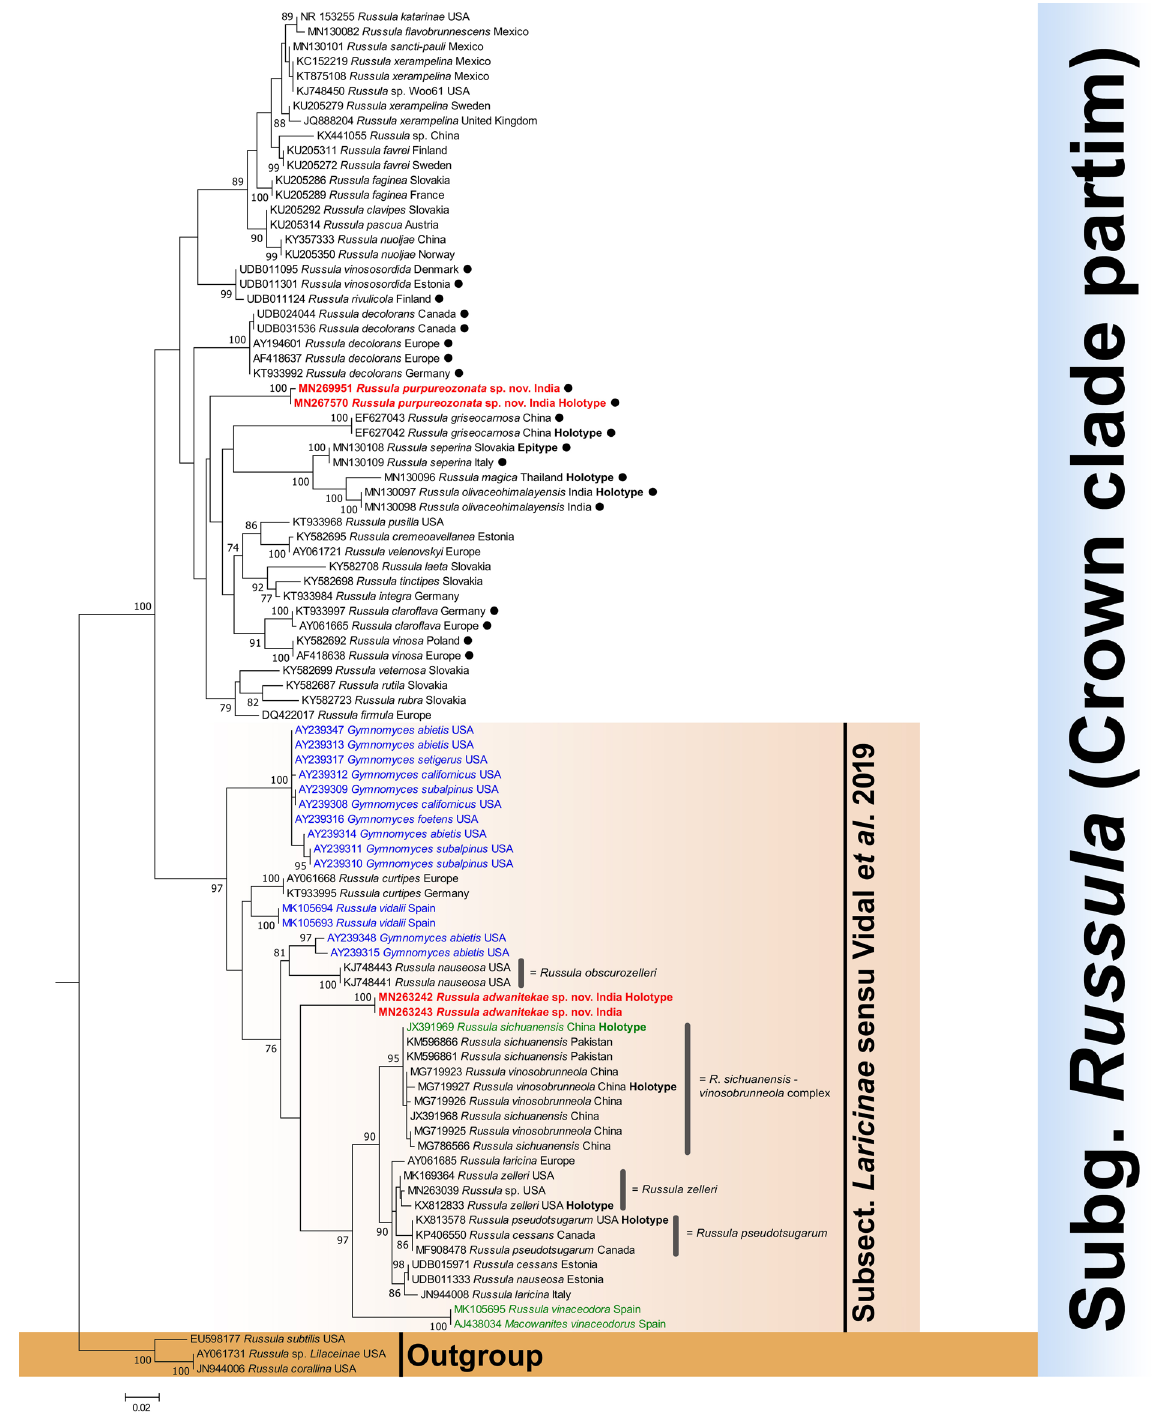
Fig. 1. Phylogram generated from rDNA ITS sequences: the evolutionary history was inferred by using the maximum likelihood (ML) method in raxmlGUI 2.0. Bootstrap support values (> 70%) obtained from the ML analysis are shown above or below the branches at nodes. Collections of the two novel Indian species described below are shown in bold red font. Secotioid taxa are shown in green font, hypogeous ones are indicated in blue font and blackening species followed by black